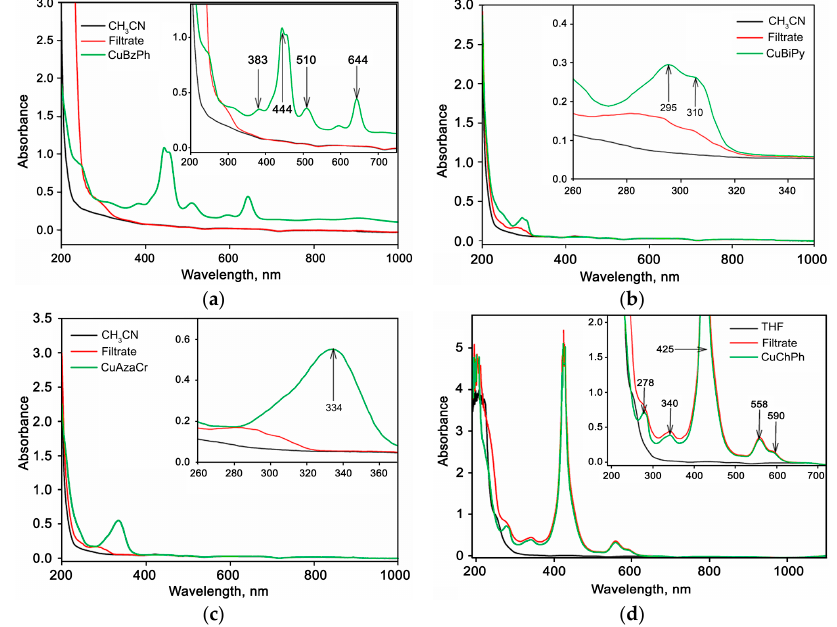
Figure 3. UV-Vis absorption spectra of pure solvents, initial solutions of Cu(II) complexes, and filtrates obtained after separation of the hybrid powder samples: ( a ) 1 × 10 − 4 M CuBzPh in CH 3 CN; ( b ) 1 × 10 − 4 M CuBiPy in CH 3 CN; ( c ) 1 × 10 − 4 M CuAzaCr in CH 3 CN; ( d ) 1 × 10 − 4 M CuChPh in